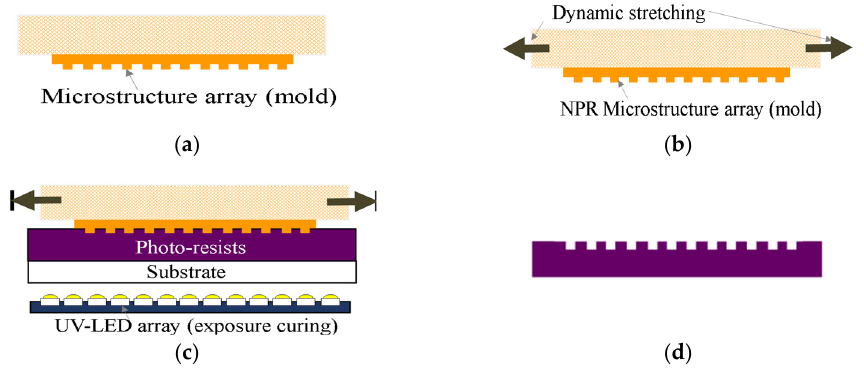
Figure 7. Uniaxial parallel flexible NPR microstructure mold replication steps ( a ) the clamping heads on both sides of the dynamic mold control system clamp the flexible NPR microstructure mold at the two ends and the photoresist is placed on the quartz glass substrate of the embossing and exposure system; ( b ) the non-uniformity of microstructure molds is dynamically controlled within the elastic range so that microstructures can be predicted and controlled within the elastic range; ( c ) the back-pressure is defined for embossing, exposure, and curing; and ( d ) demolding is carried out next to obtain finished